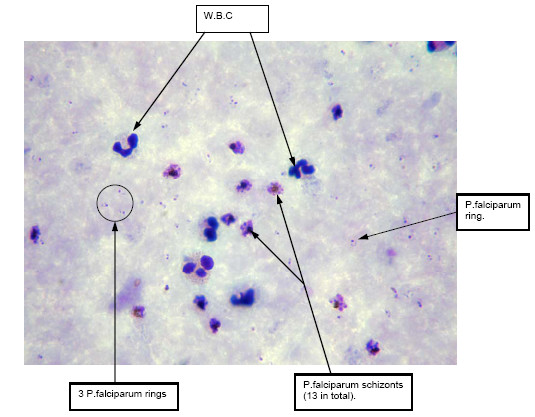
Thick blood film of patient on admission demonstrating significant presence of schizonts compared with trophozoites (oil immersion × 1000).